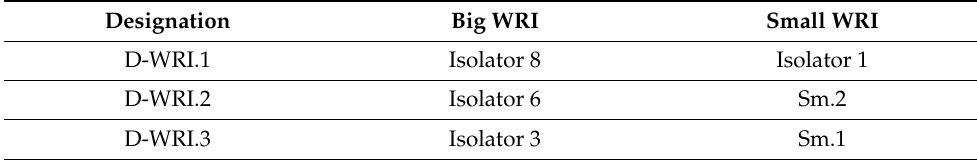
Table 5. Configurations of the outer and inner WRIs in D-WRIs.